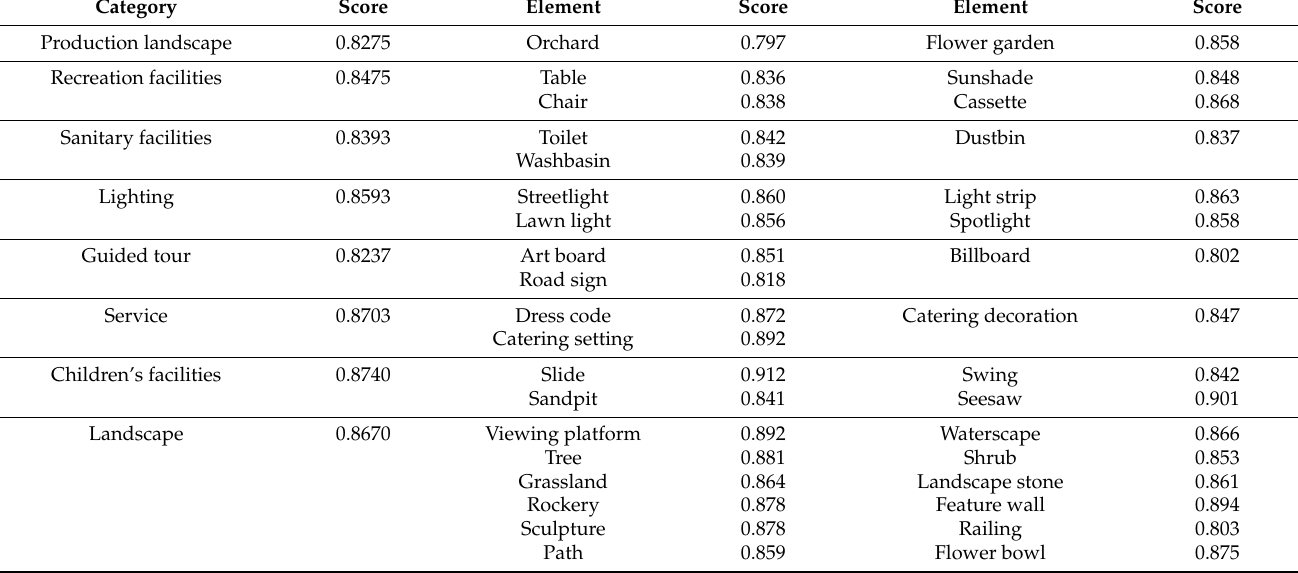
Table 2. Overall landscape categories and elements preference.